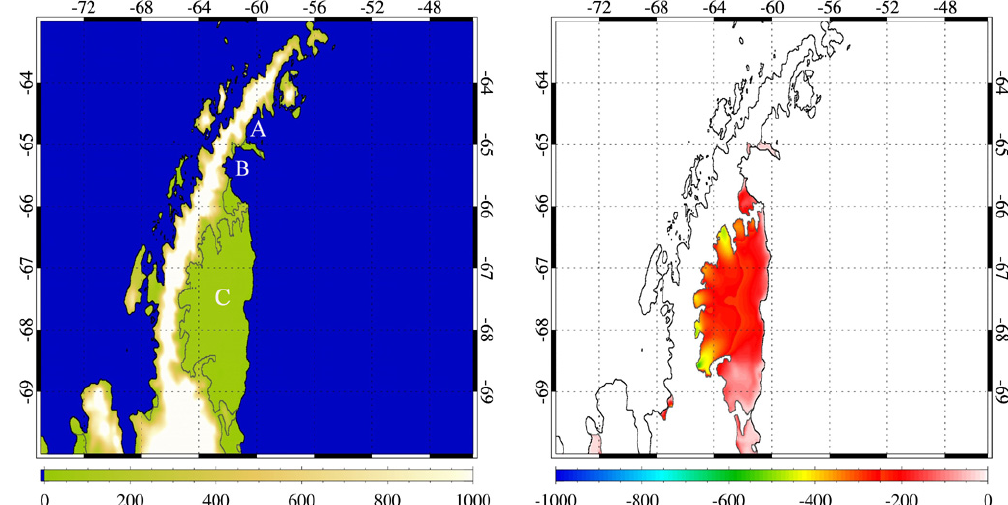
Figure 4. Surface elevation (left) and ice shelf draft (right) for the Antarctic Peninsula, including Larsen C ice shelf and the remnants of Larsen B ice shelf. The ice shelf front is marked with a black line, the grounding line location with a grey line. The letters A / B / C mark the (former) Larsen A, B and C Ice